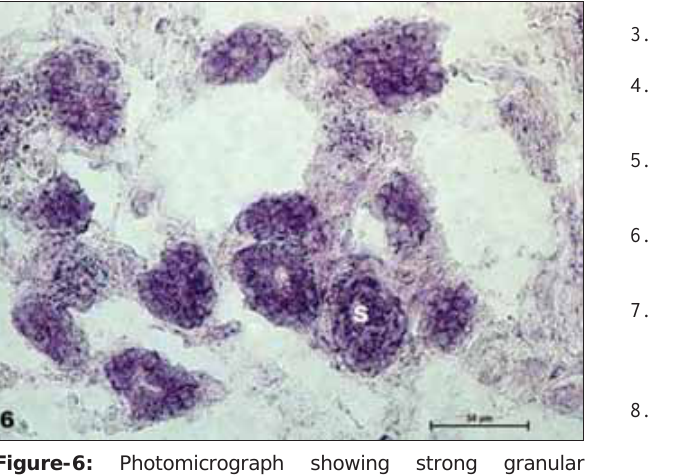
Figure-6: Photomicrograph showing strong granular succinic dehydrogenase activity in serous acinar cells (S)